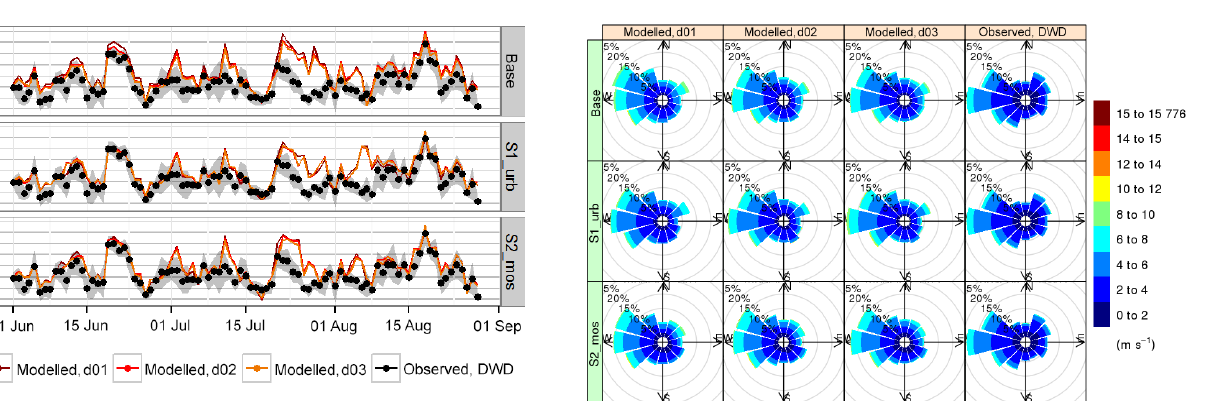
Figure 7. Daily mean observed and modelled wind speed from the base run, S1_urb and S2_mos, for all three model domains (d01 – 15km horizontal resolution, d02 – 3km, d03 – 1km). The figures show means over the daily means of three stations in Berlin (Tegel, Schönefeld and Tempelhof). The grey shades show the variability between the daily means of these stations, corresponding to the 25th and 75th percentiles of the individual stations’ daily means. For the model results, the grid cells corresponding to the location of the stations were extracted.